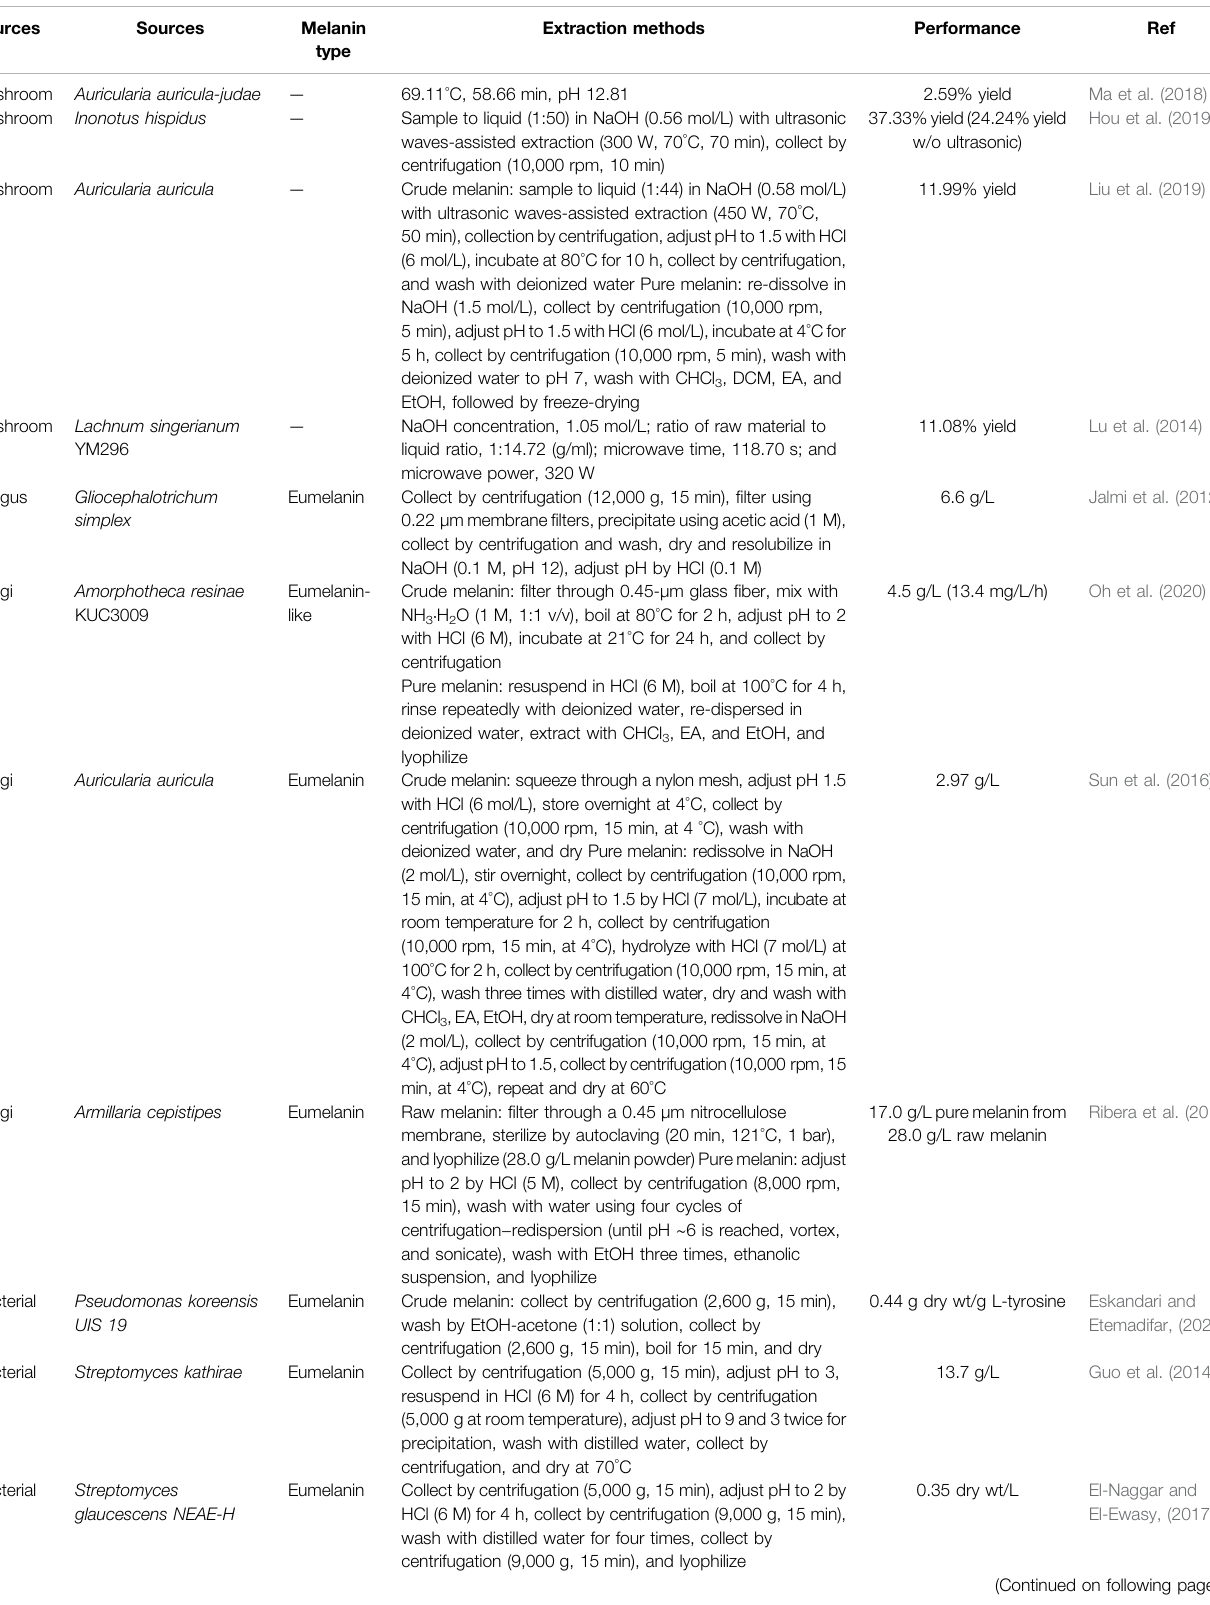
TABLE 2 | Extraction and puri fi cation process details in melanin biore fi